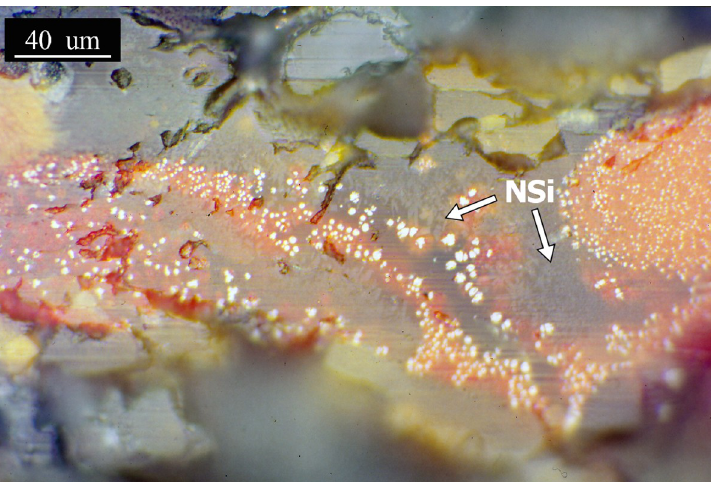
Fig 13. PPL micrograph of PA6325 showing whitish prills of cuprite, its reddish exsolution and small neosilicates (NSi, light grey) in the darker grey matrix. (Scale = 40 μ m).